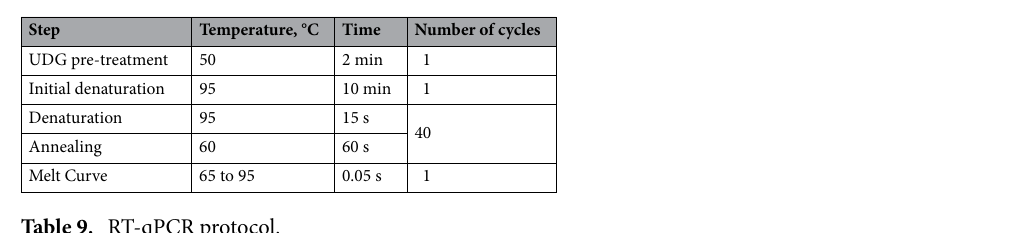
Table 9. RT-qPCR